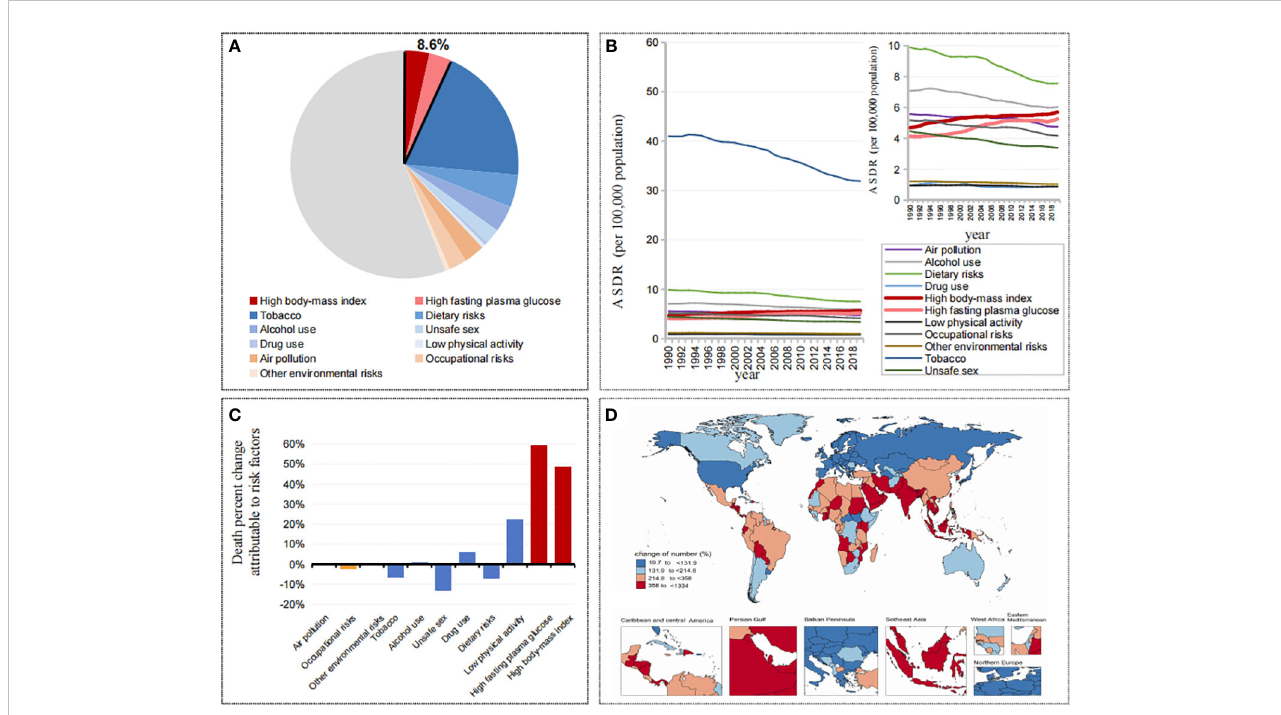
FIGURE 1 (A) Contributions of attributable death cases by different risk factors in 2019. (B) The trend of ASDRs in cancers attributable to different risk factors from 1990 to 2019. (C) Changes of death percent in cancers attributable to different risk factors from 1990 to 2019. (D) Changes of death cases in cancers attributable to metabolic factors by countries and territories from 1990 to